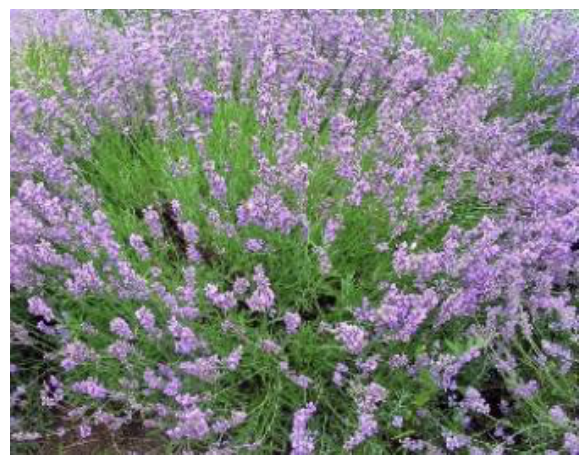
Figure 6. Lavender plant [61].